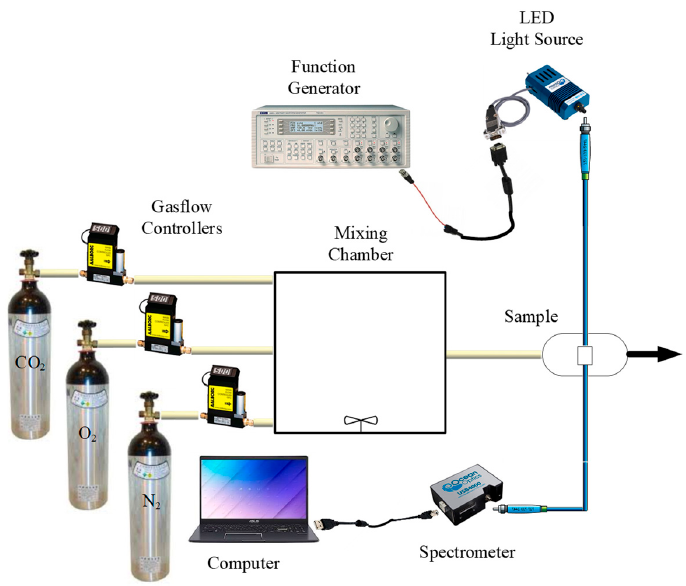
Figure 2. Schematic diagram showing experimental arrangement used for characterization.